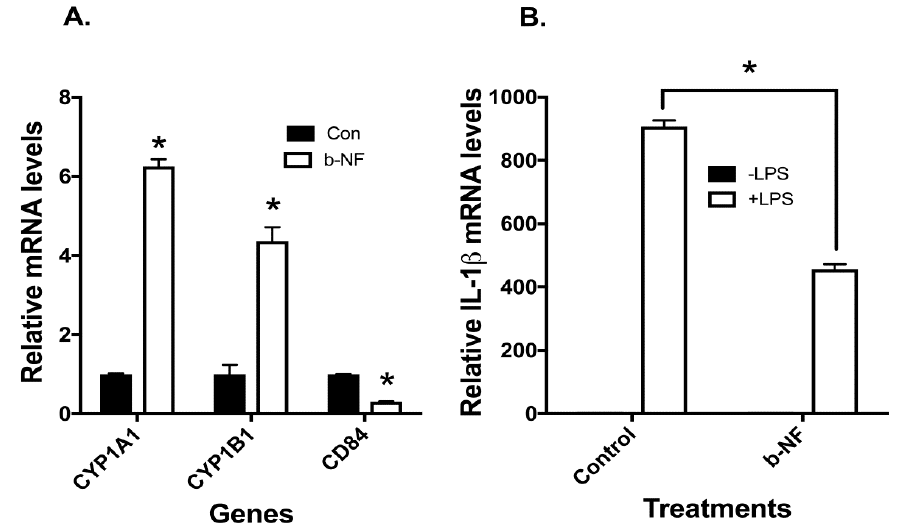
Figure 6. Effects of AHR agonist beta-naphthoflavone (b-NF) on CYP1A1/B1, CD84, and LPS-induced IL-1 β mRNA expression in u-THP-1 cells. U-THP-1 cells were treated with or without b-NF (10 µM) as described in Materials and Methods. After treatment with the compounds, cells were exposed to LPS for an additional 2 h. After LPS treatment, total RNA was isolated and CD84, CYP1A1/B1 and IL-1 β mRNA expression were determined using RT-PCR. ( A ) Effects on CYP1A1/B1, CD84 expression; ( B ) Effects on LPS induction of IL-1 β mRNA expression. Results are expressed as mean ± SD ( n = 3). * indicates significant difference from vehicle control at p ≤ 0.05.